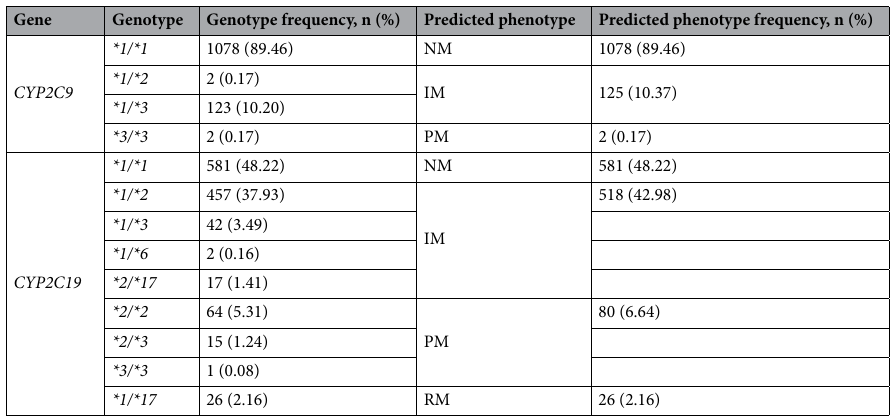
Table 4. Frequencies of the CYP2C9 and CYP2C19 genotypes and predicted phenotypes in a sample of the Thai population (n = 1205). NM normal metabolizer, IM intermediate metabolizer, PM poor metabolizer, UM rapid